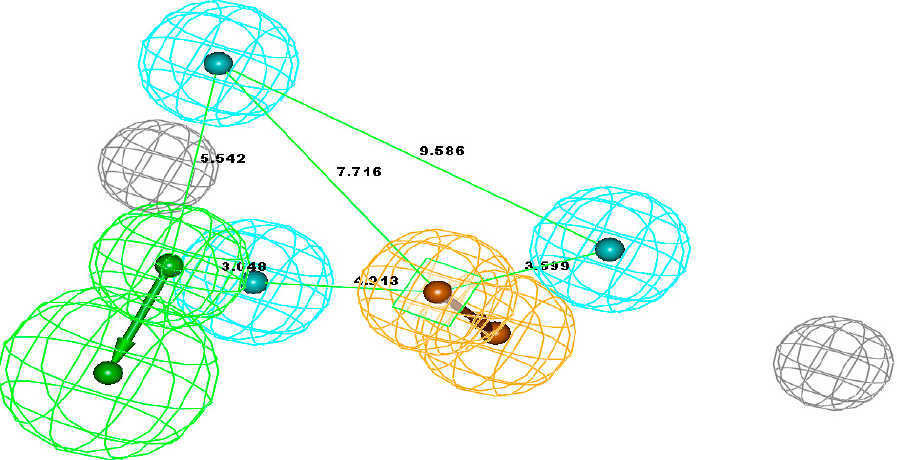
Figure 1. The best hypothesis = Hypo-1. Pharmacophore features: Green—HBAL, Orange—RA, blue—HY. Distance between pharmacophore features is indicated in angstrom ( Ǻ ).